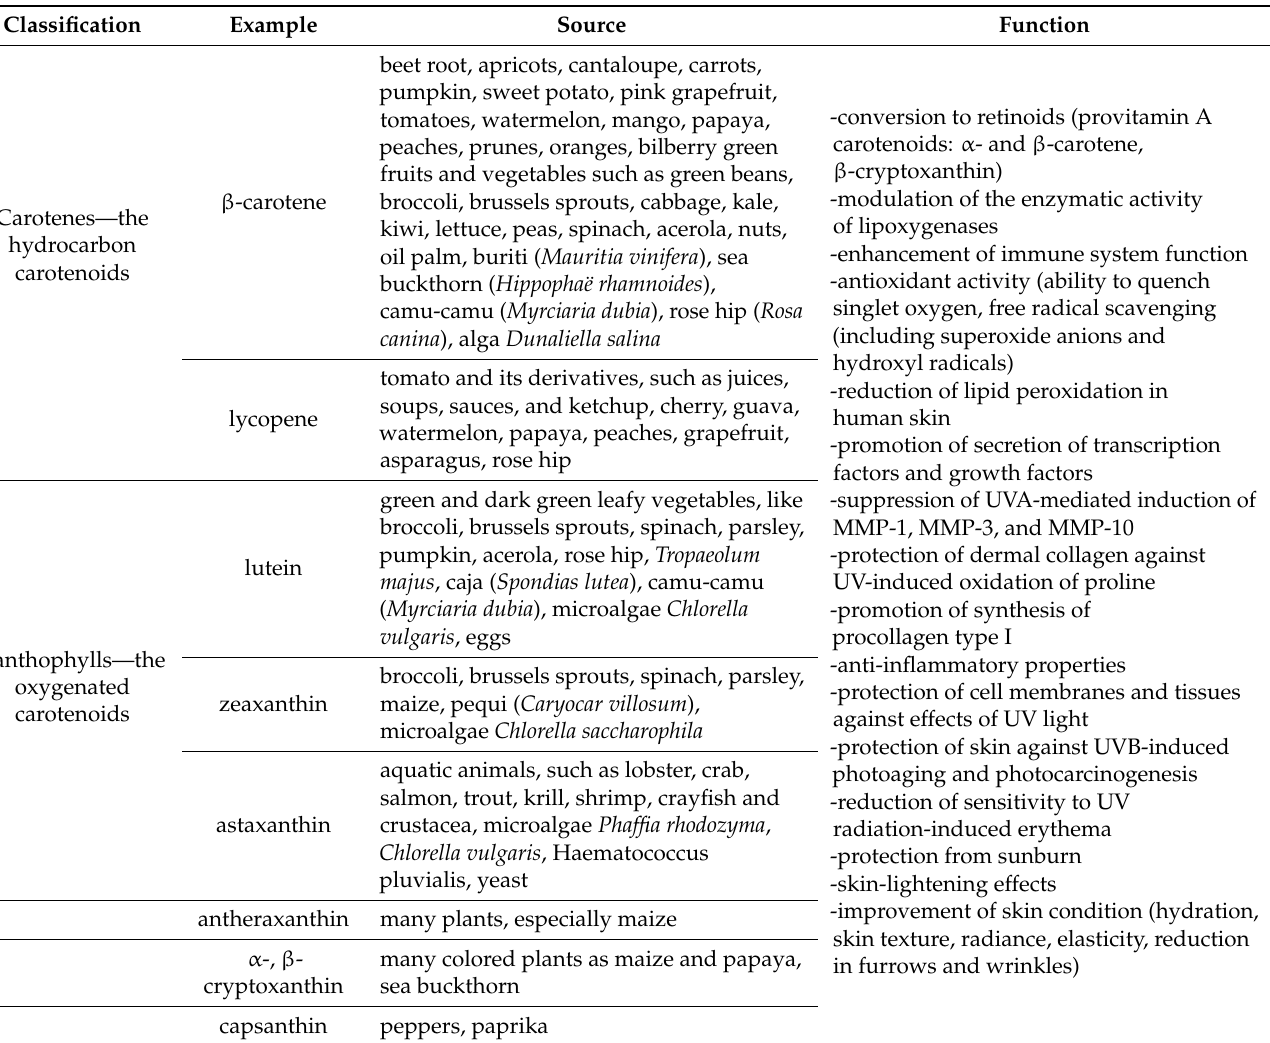
Table 3. Classification of carotenoids, and their sources, functions and importance in skin health [219–228].